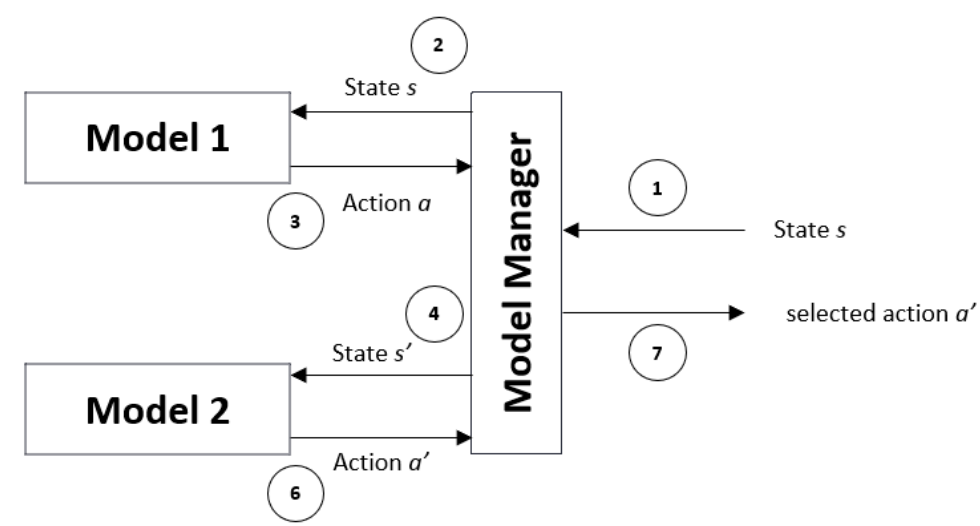
Figure 7. Model manager in the testing phase.